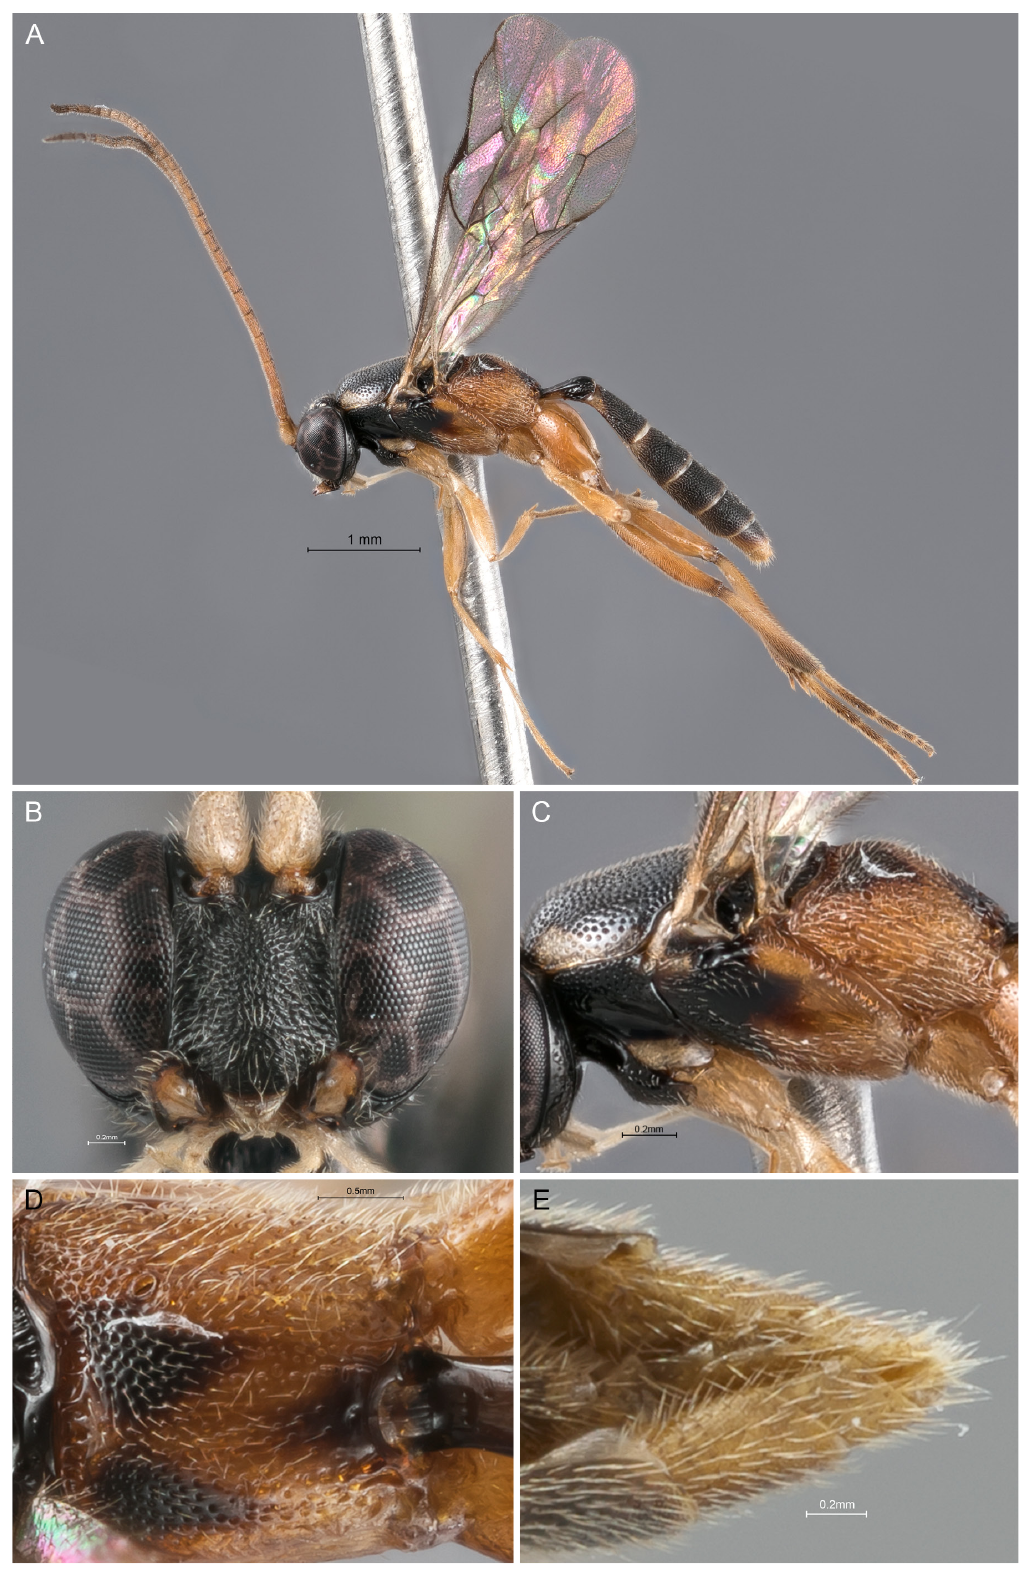
Fig. 19. Palpostilpnus tamasek sp. nov., paratype, ♂ (LKCNHM). A . Lateral habitus. B . Head, anterior view. C . Mesopleuron. D . Propodeum. E . Hypopygium, ventral